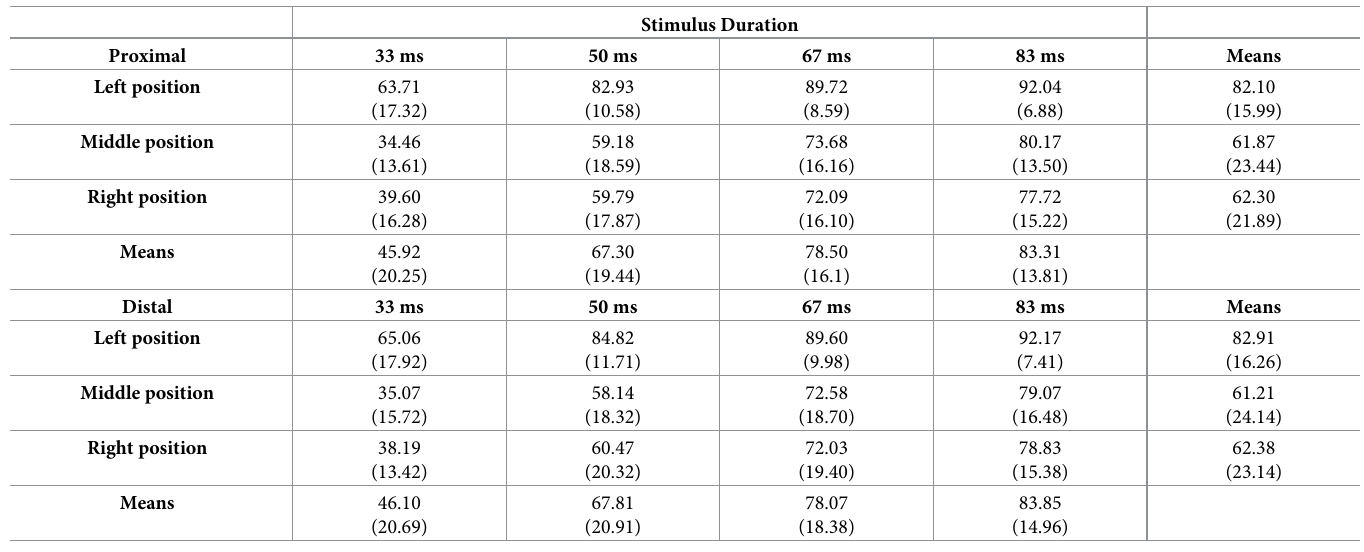
Table 1. Mean accuracies by